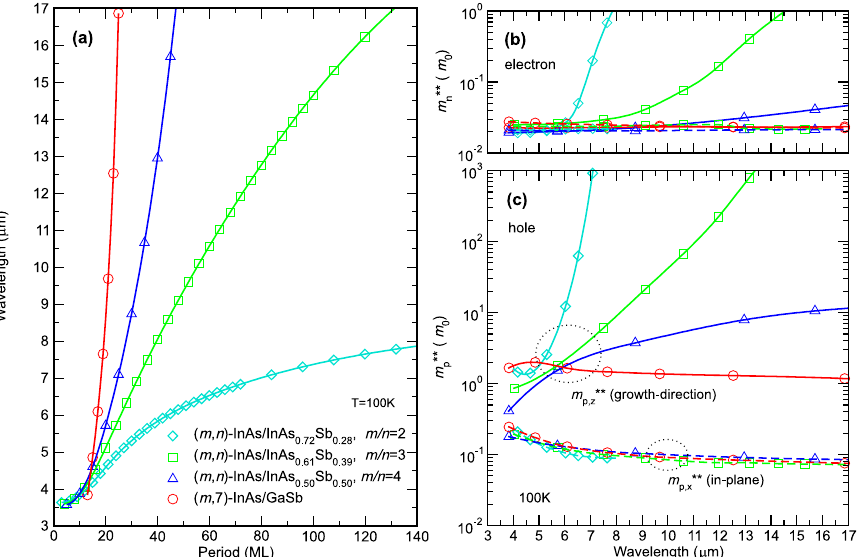
Figure 1. ( a ) Calculated cutoff wavelengths for three families of InAs/InAsSb superlattices as functions of superlattice period in monolayers (MLs). The results for a set of InAs/GaSb superlattice is included for comparison, ( b ) electron conductivity effective masses along the growth direction z ( m n,z **, solid lines) and in-plane direction x ( m n,x **, dashed lines) plotted against cutoff wavelength for the same set of superlattices, and ( c ) the corresponding hole conductivity effective masses m p,z ** and m p,x